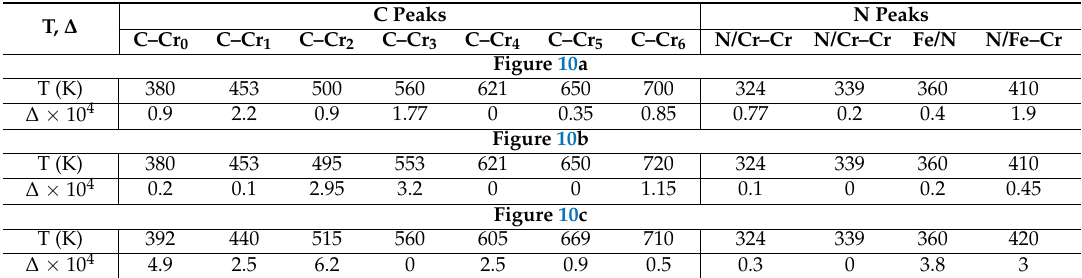
Table 8. Temperatures T and relaxation strengths Δ of the Q − 1 peaks used to fit MS experimental data displayed in Figure 10 for the samples heat treated up to 673, 773, and 873 K. C Peaks N Peaks T, Δ C–Cr 0